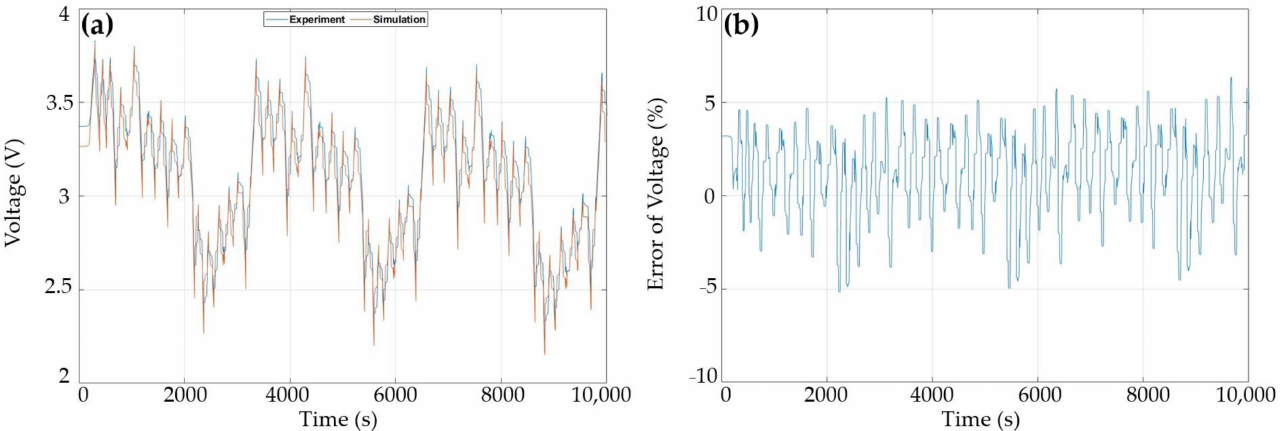
Figure 10. Verification of the electrical model: ( a ) the voltage simulation results against experiments, and ( b ) the voltage error